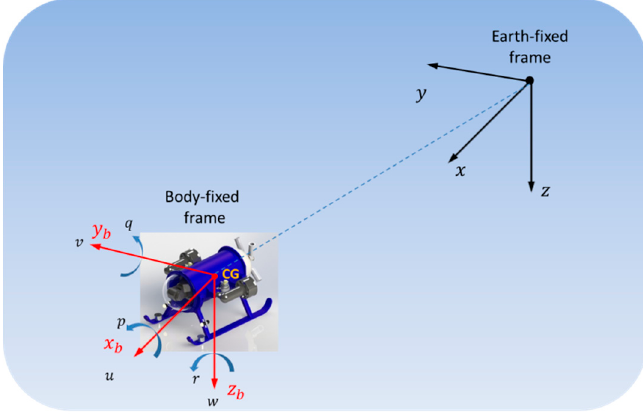
Figure 1. Coordinated frames used in the modeling and analysis of underwater vehicles.